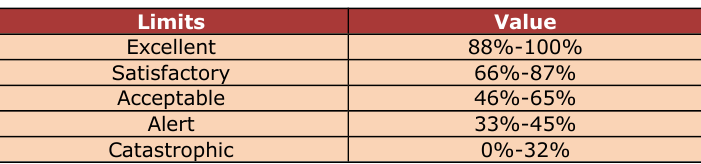
Table 3. Limit values between states in green design criterion